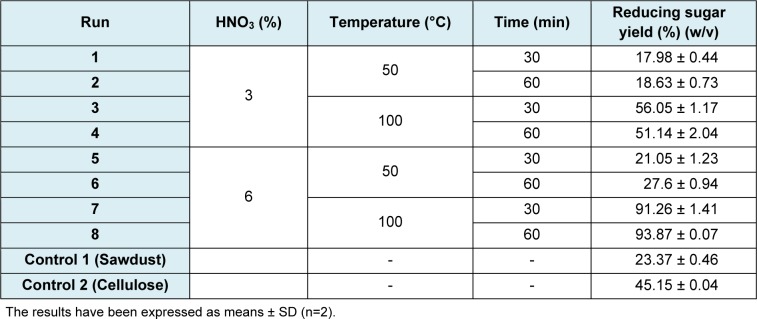
Design matrix (23) of hydrolysis and results